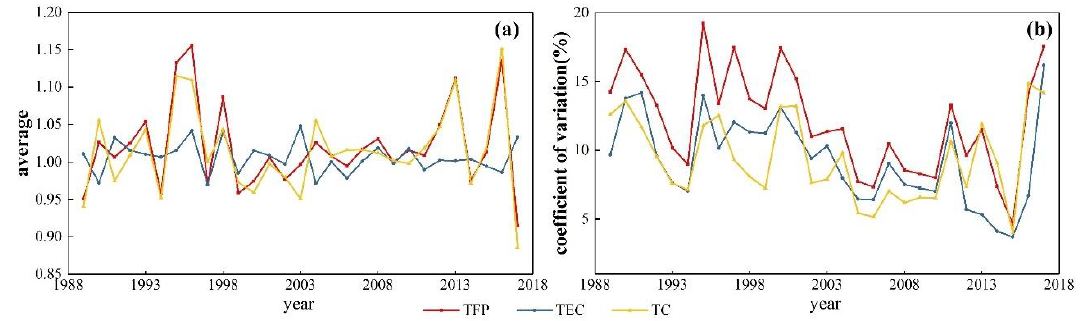
Figure 4. Trends of ( a ) agricultural TFP, TEC, and TC of Gansu Province and ( b ) their coefficients of variation with time.